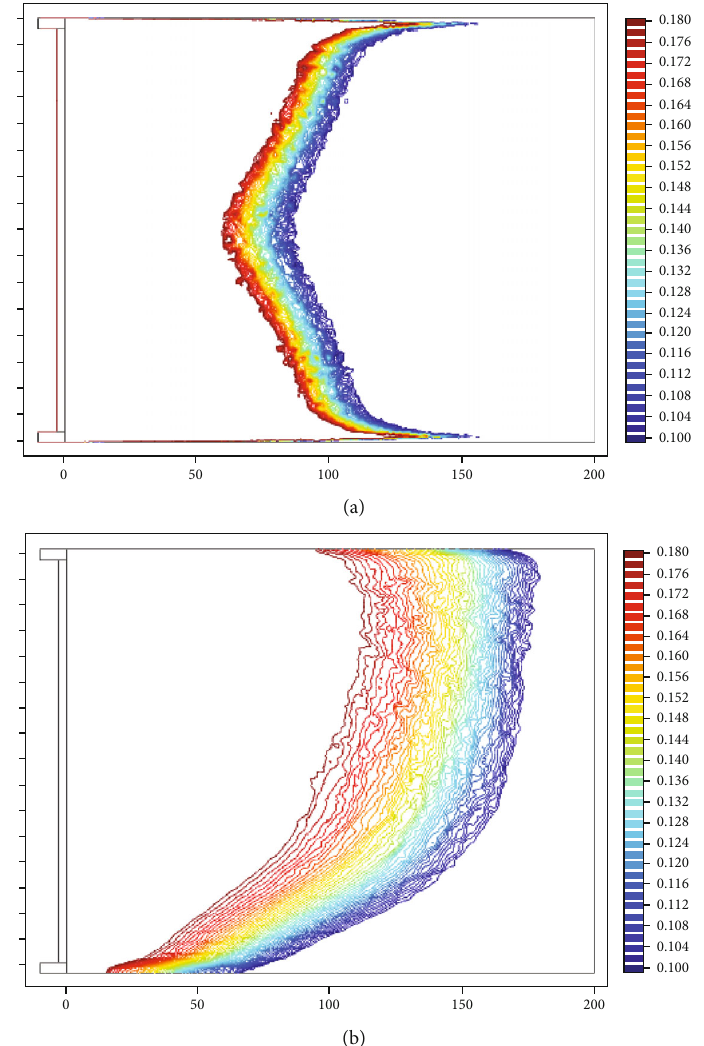
Figure 10: Distribution of oxidation zone at z = 1 : 5 m in goaf fl oor.